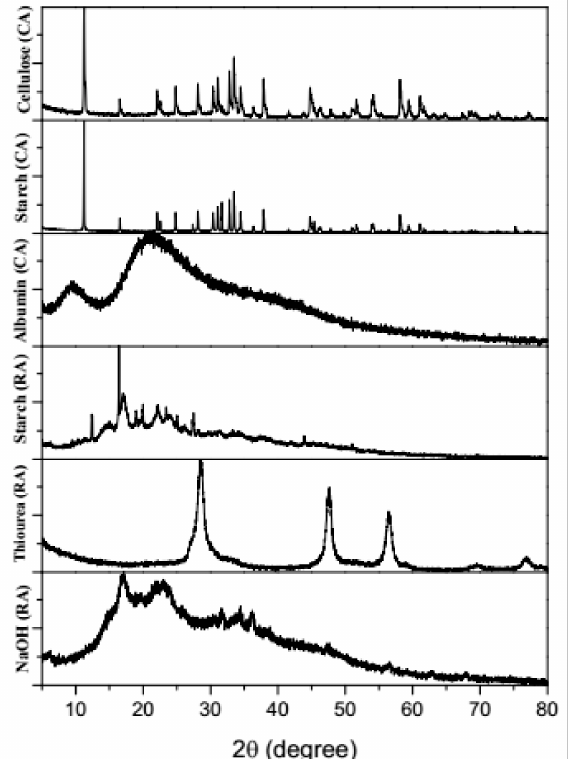
Figure 4. X-ray diffraction spectroscopy of the synthesized ZnNPs depicting the formation of wurtzite hexagonal crystal structure zincite (ZnO) on the use of various reducing and capping/complexing agents i.e., Sodium hydroxide (RA), Thiourea (RA), Starch (RA), Bovine serum albumin (CA), Starch (CA), and Cellulose